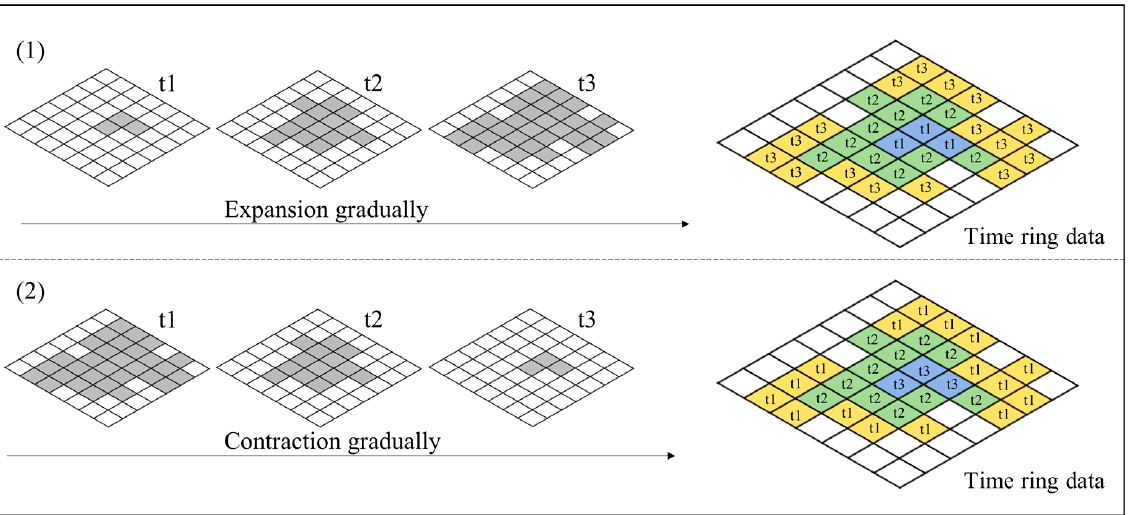
Figure 1. The general form of time ring (TR) data: ( 1 ) for spatially expansive feature; and ( 2 ) for spatially contractive feature.